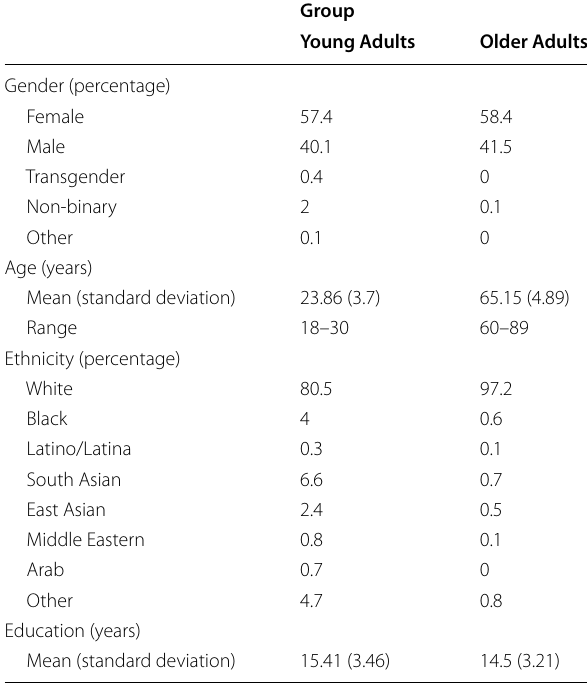
Table 1 Demographic data for young and older groups